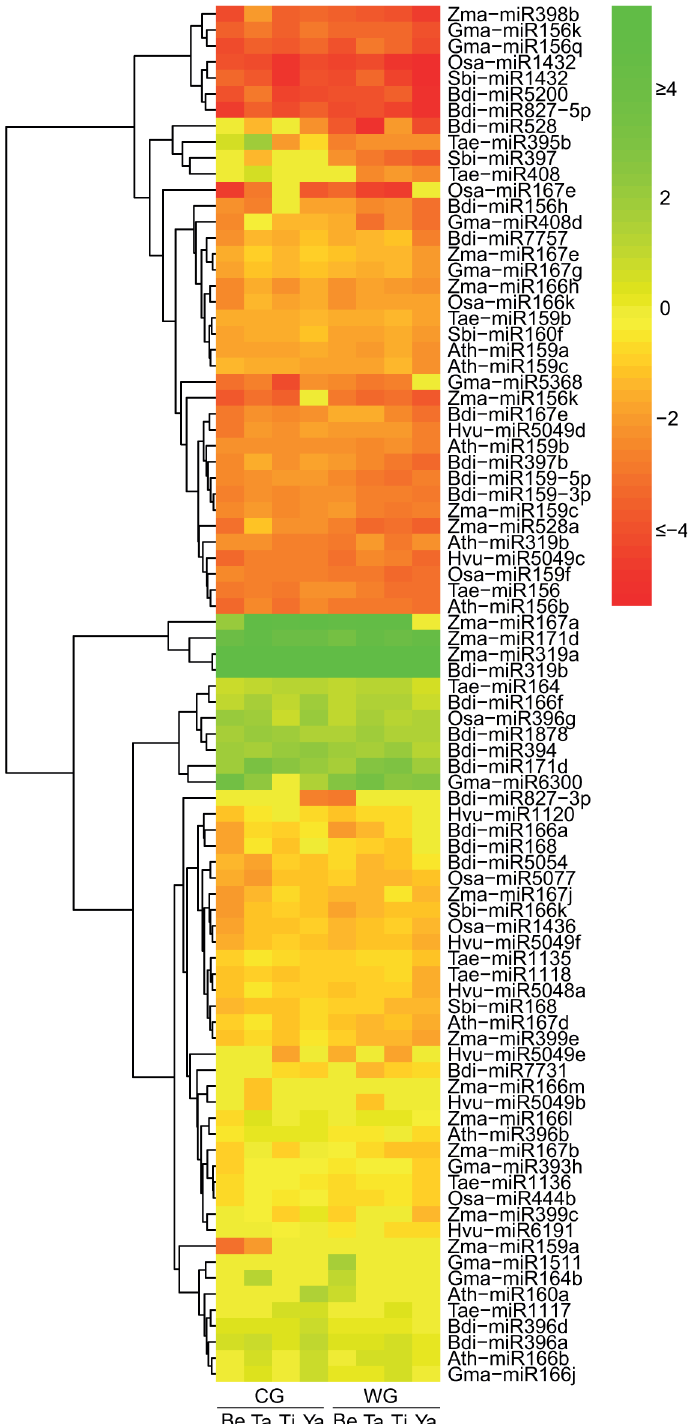
Fig 2. Heat-map showing differential expression patterns of conserved miRNAs between different tissues revealed by high-throughput sequencing. The colour scale is based on the log2 value of the fold- change of the developing head libraries compared to the flag leaf libraries in four durum genotypes under different water treatments. Log2 value = log2 (RPM of miRNA reads in head libraries/RPM of miRNA reads in flag leaf libraries). The red colour indicates that the miRNA was more abundant in the flag leaf libraries; while the green colour indicates that the miRNA was more abundant in the developing head libraries. CG =